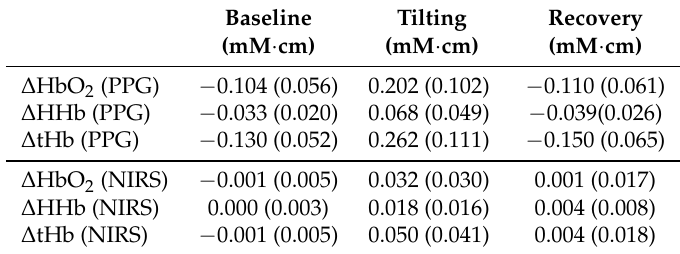
Table 1. Median changes (IQR = Q 3 − Q 1 ) of relative haemoglobin concentrations changes estimated by PPG and NIRS during baseline, tilting, and recovery. The PPG-derived haemoglobin concentrations refer to the PPG-2 sensor, which was placed above the eyebrow. The values are averaged over the central three minutes of baseline, tilting, and recovery. Values in mM · cm.